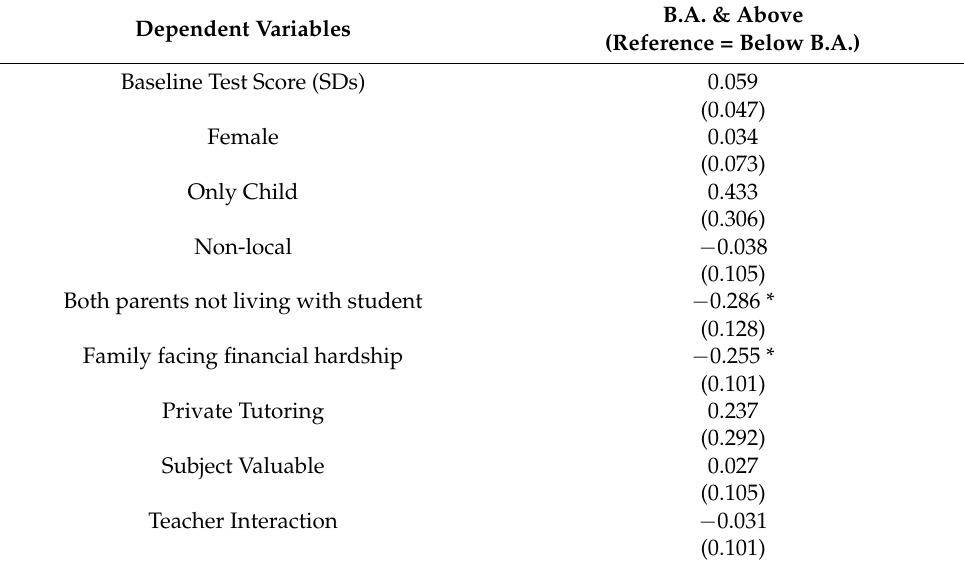
Table 4. Test of random class assignment (N =